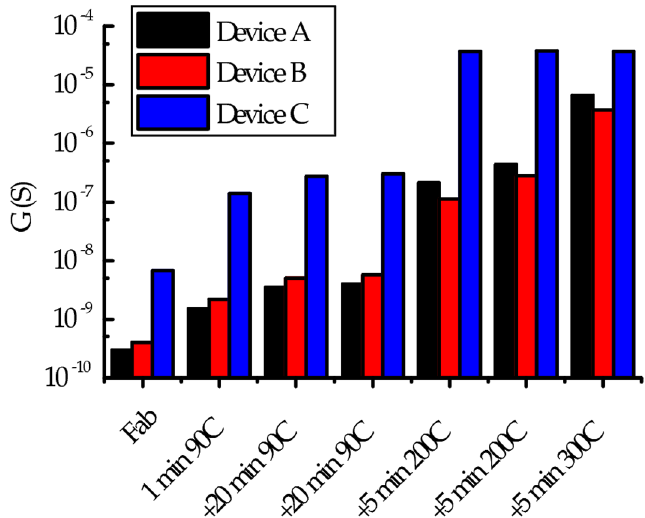
Figure 4. Measurement of three Pt ‐ Al 2 O 3 ‐ Pt devices from the same die displaying how successive treatments using longer exposures to forming gas and higher temperatures caused further increases in conductance.